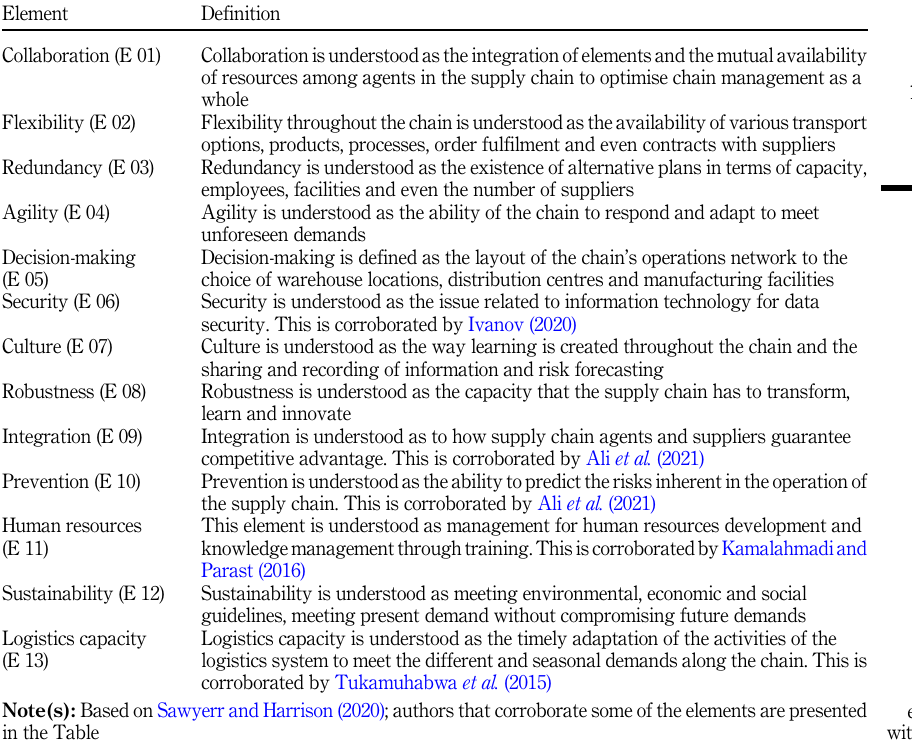
Table 1. Definition of the elements associated with resilience in